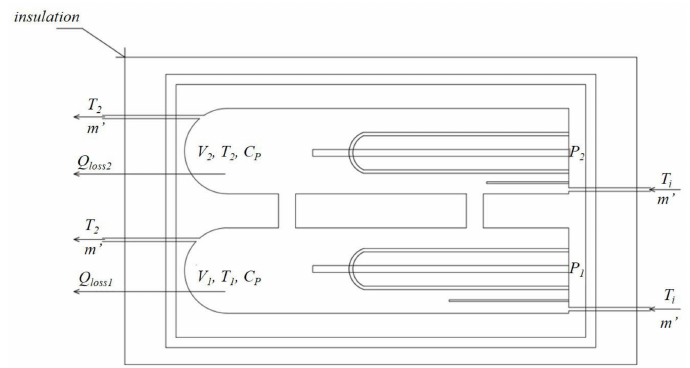
Figure 3. Model of a dual-tank water heater showing flow rate, energy, temperature and volume. To obtain the overall EWH volumes and power ratings ( V = V 1 + V 2 and P = P 1 + P 2 ), the two tanks’ individual volumes and power ratings were added. Each tank’s volume and power rating were adjusted for maximal hot water delivery and the greatest possible energy-saving arrangement. For the first and second tanks, the transient energy balances are given in Equations (4) and